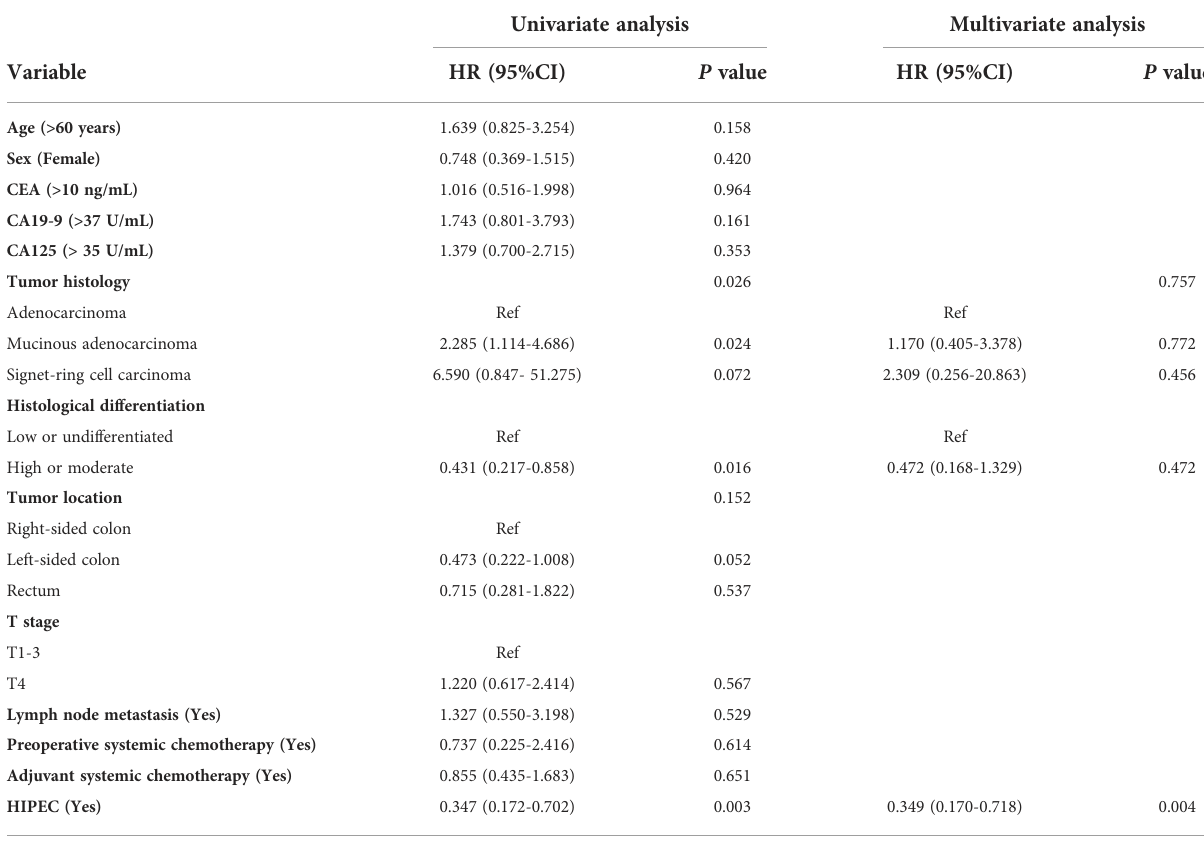
TABLE 2 Univariate and multivariate analyses for OS of CRC patients with isolated synchronous colorectal peritoneal metastases using the Cox proportional hazards regression. Univariate analysis Multivariate